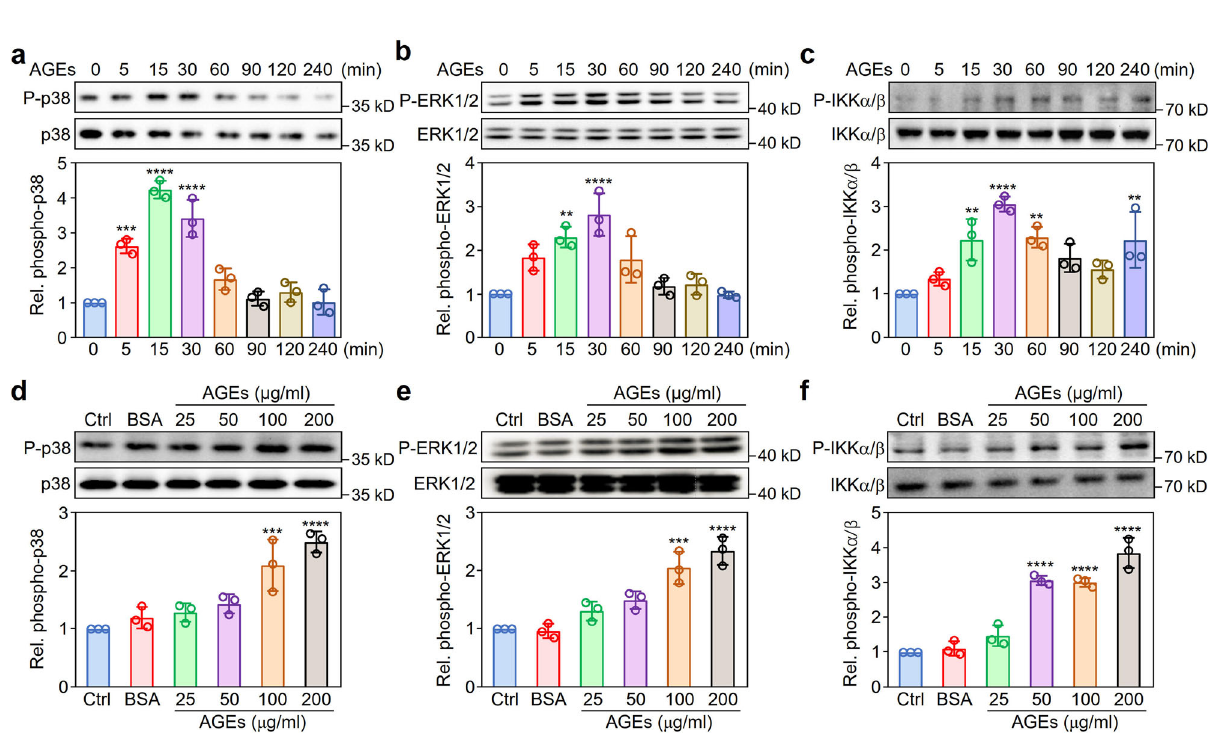
Fig. 3 Effect of AGEs on proin fl ammatory signaling pathways in macrophages. a – c Activation dynamics of p38 MAPK, ERK1/2, and IKK α / β in RAW264.7 cells induced by AGEs. After treatment with AGEs (100 μ g/ml) for different times (0 – 240 min), RAW264.7 cells were harvested for western blotting with speci fi c antibodies against phosphorylated (upper panel) or total (lower panel) p38 MAPK ( a ), ERK1/2 ( b ), or IKK α / β ( c ). d – f Dose-dependent activation of p38 MAPK, ERK1/2, and IKK α / β in RAW264.7 cells stimulated with AGEs. RAW264.7 cells were treated with AGEs at the indicated doses for 15 min. Western blotting was performed with speci fi c antibodies to detect phosphorylation of p38 MAPK ( d ), ERK1/2 ( e ), and IKK α / β ( f ). Protein band densities were quanti fi ed with ImageJ software and are presented as fold changes (FC) in the phosphorylated kinase relative to the corresponding total kinases. Data from three independent experiments ( n = 3) are shown as the mean ± SD values. ** P < 0.01, *** P < 0.001, **** P < 0.0001 versus untreated cells (one-way ANOVA plus Tukey post hoc). Source data are provided as a Source data fi high mobility group box 1 protein (HMGB1) was prominently elevated 6 h after CLP and increased further until the end of the 24-h observation period (Fig. 6c).